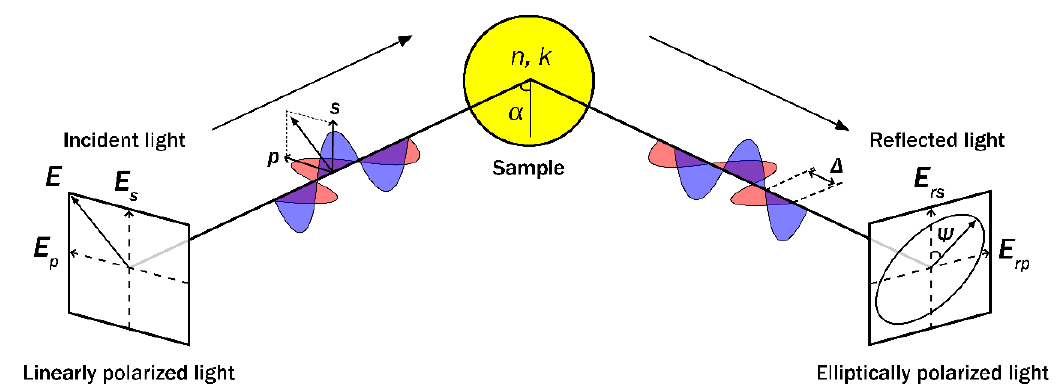
Figure 2. Schematic representation of ellipsometric measurements. E –electric field vector, E s –component of electric field vector perpendicular to the plane of incidence E p –component of electric field vector parallel to the plane of incidence, n –refractive index of the sample, k –extinction co- efficient of the sample, E rs , E rp –perpendicular and parallel reflected field amplitudes. Ψ –ellipsometric parameter that corresponds to amplitudes ratio upon reflection, ∆ –ellipsometric parameter that corresponds to phase difference between p - and s - polarizations, α - angle of incident light.